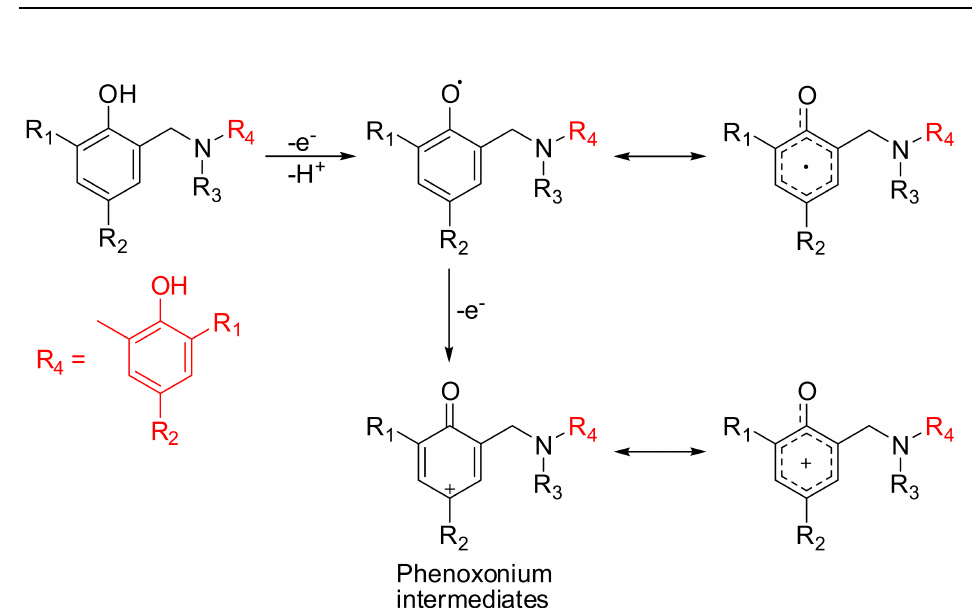
Figure 7. Proposed mechanism for the first oxidation of the dihydro-benzoxazine